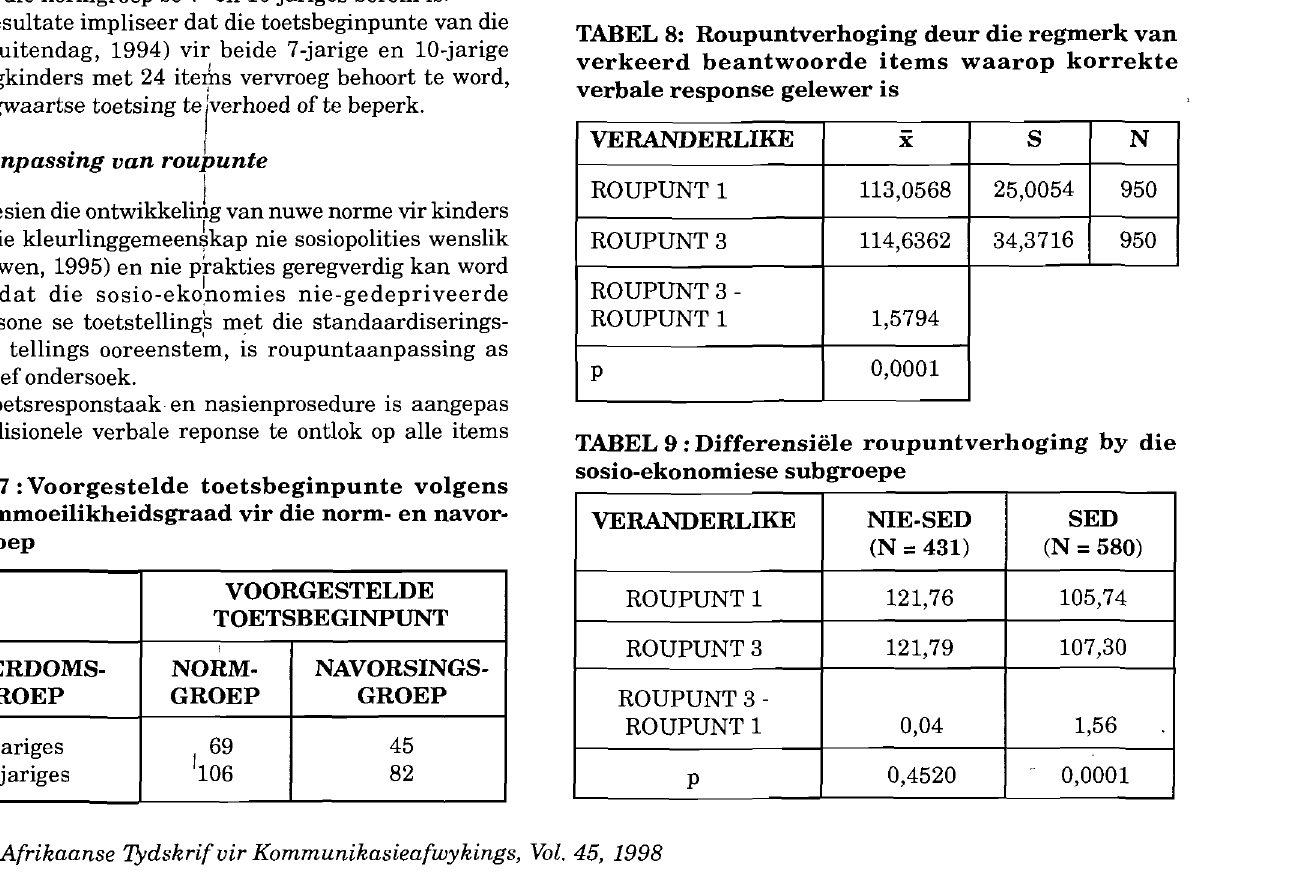
TABEL 8: Roupuntverhoging deur die regmerk van verkeerd beantwoorde items waarop korrekte verbale response gelewer is